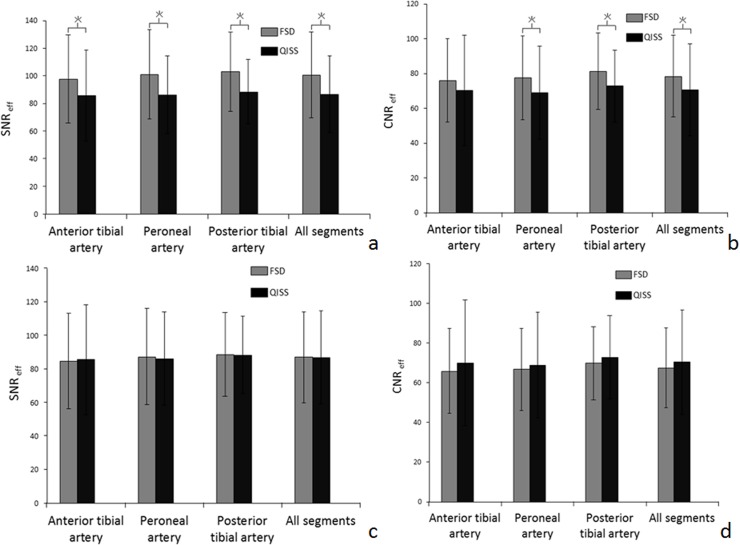
Comparison of the time efficiency of SNR (SNR eff) and CNR (CNR eff) between QISS and FSD with only dark and bright blood scan (a, b) or adding the phase-contrast and m1-scout scan (c, d)) in three arterial segments of the calf.Each column represents average measurements and error is shown as standard deviation. Asterisks indicated significant difference (P < 0.05). SNR: signal-to-noise ratio; CNR: contrast-to-noise ratio; QISS: quiescent-interval single-shot; FSD: flow-sensitive dephasing.